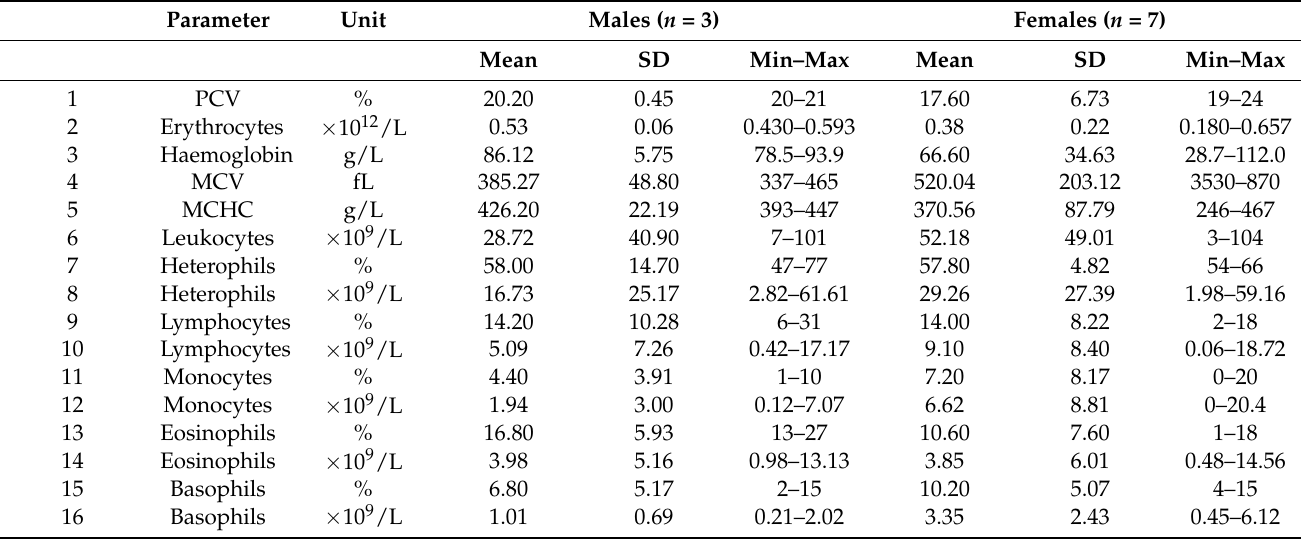
Table 5. Comparison of the Hematological Profile between Male and Female False Gharial ( n = 10). For each parameter the mean and the standard deviation (SD), as well as the minimum (Min) and maximum (Max) range are reported.